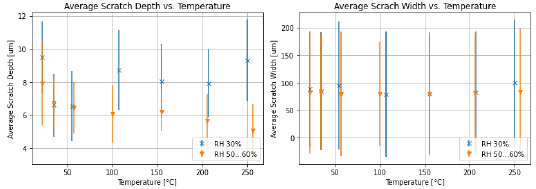
Fig. 3. Average scratch depth for both glass samples at different relative humidity (left side) and maximum scratch width for both glass samples at different relative humidity (right side)